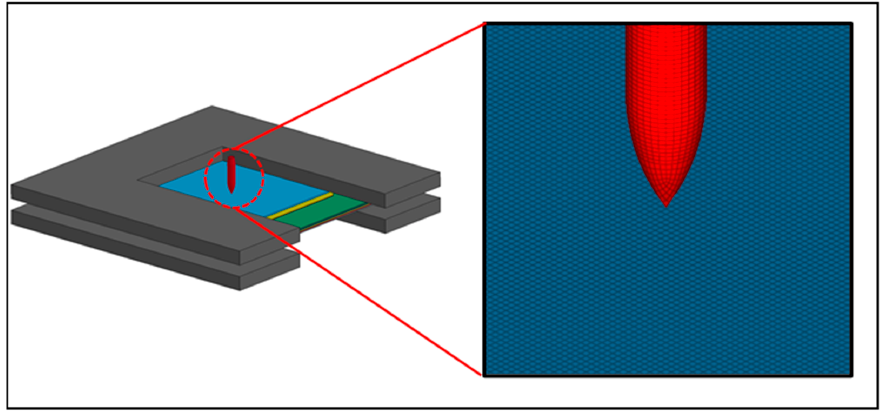
Figure 5. Finite element model of the composite structure.